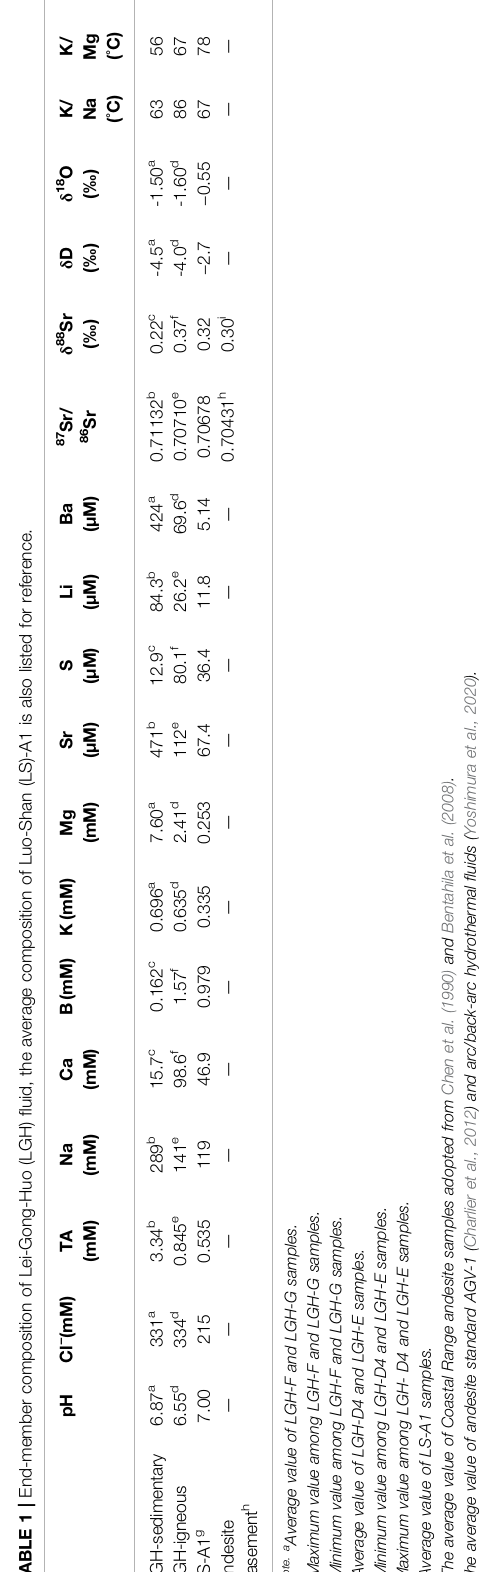
dehydration fl uid coupled with further chloride